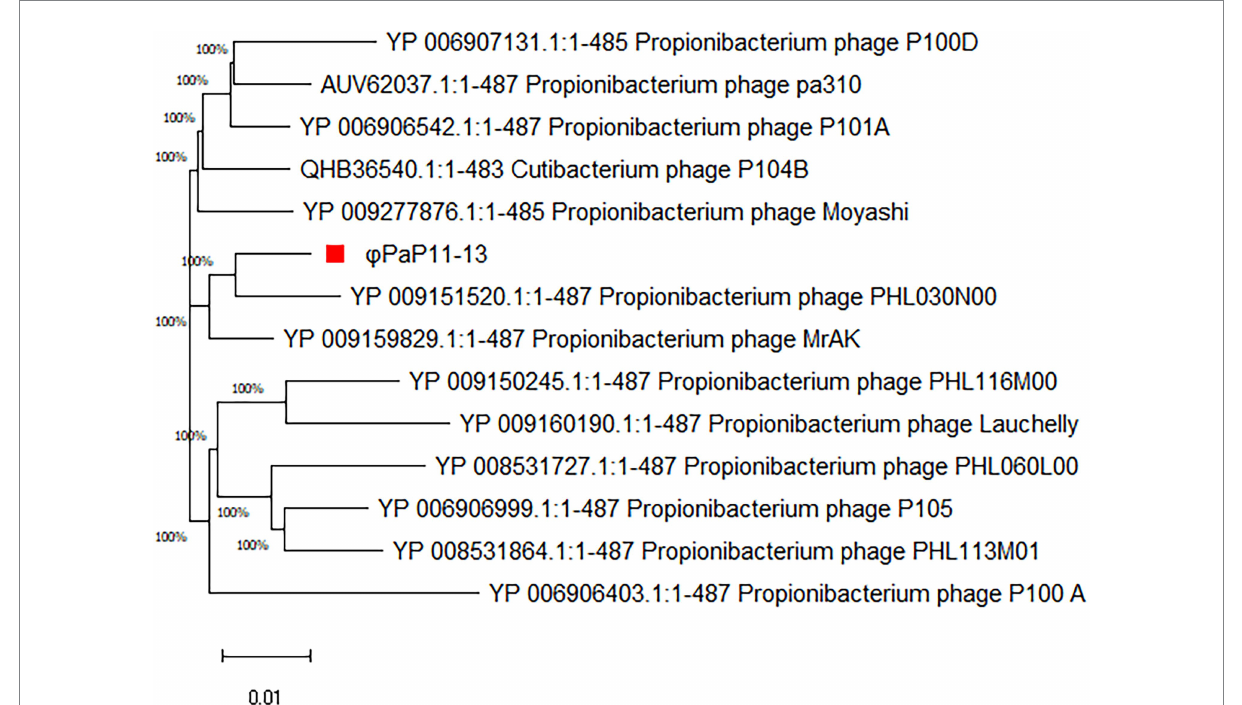
FIGURE 9 Phylogenetic analysis of φ PaP11-13. The number in the phylogenetic tree is the phage accession number, and the number on the branch represents the